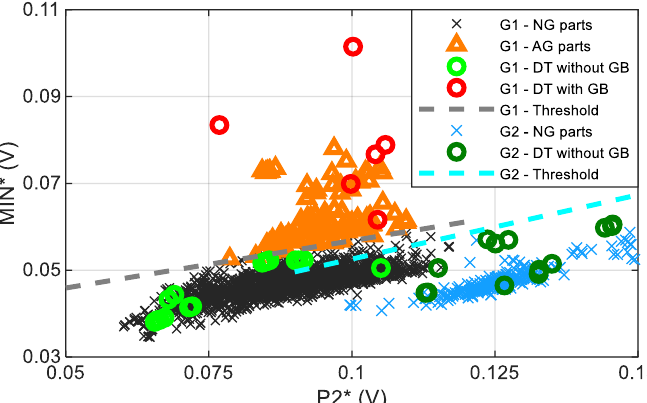
Figure 11. The mean value of parameter MIN (MIN*) obtained throughout the effective length of the ball screw shaft thread as a function of the mean value of P2 (P2*) for all the different groups labelled as: “G1-NG parts” (normally ground parts of G1), “G1-AG parts” (abnormally ground parts of G1), “G1-DT without GB” (correct part (without grinding burn (GB)) verified via destructive testing (DT) results of G1), “G1-DT with GB” (part with grinding burn (GB) verified via destructive testing (DT) results of G1), “G1-Threshold” (threshold value of MIN* as a function of P2* of group G1), “G2-NG parts” (normally ground parts of G2), “G2-DT without GB” (correct part (without grinding burn (GB)) verified via destructive testing (DT) results of G2), “G2-DT with GB” (part with grinding burn (GB) verified via destructive testing (DT) results of G2) and “G2 - Threshold” (thresh- old value of the MIN* as a function of P2* of group G2). The standard deviation of MIN* is 0.6 mV and of P2* is 1.6 mV.